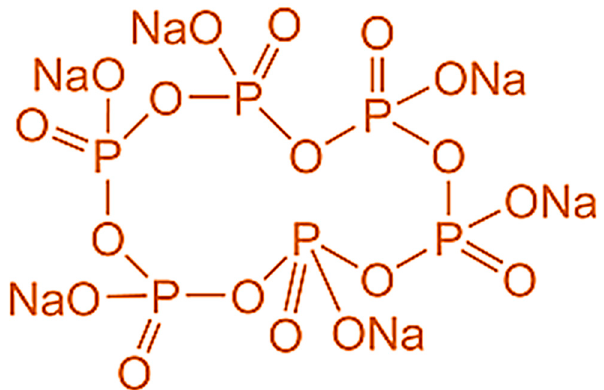
Figure 1. Chemical structure of sodium hexametaphosphate (SHMP).